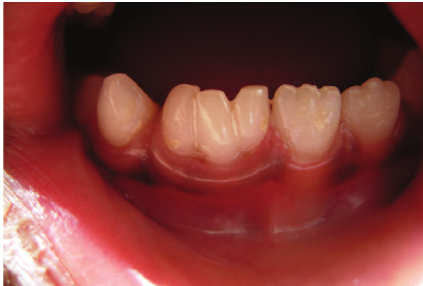
Figure 1: Image of lower arch showing fusion of two primary incisors with supernumerary tooth.